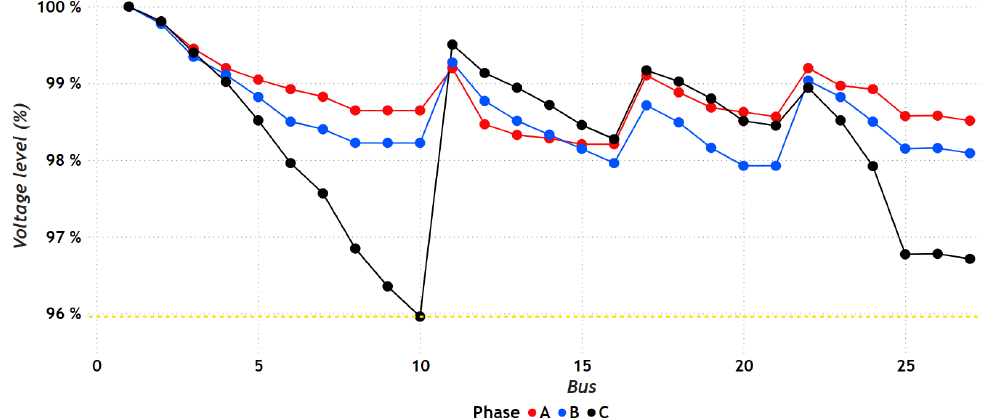
Figure 15. Behavior of the voltage profiles in the three-phase 27-bus distribution system under an unbal-anced load scenario.